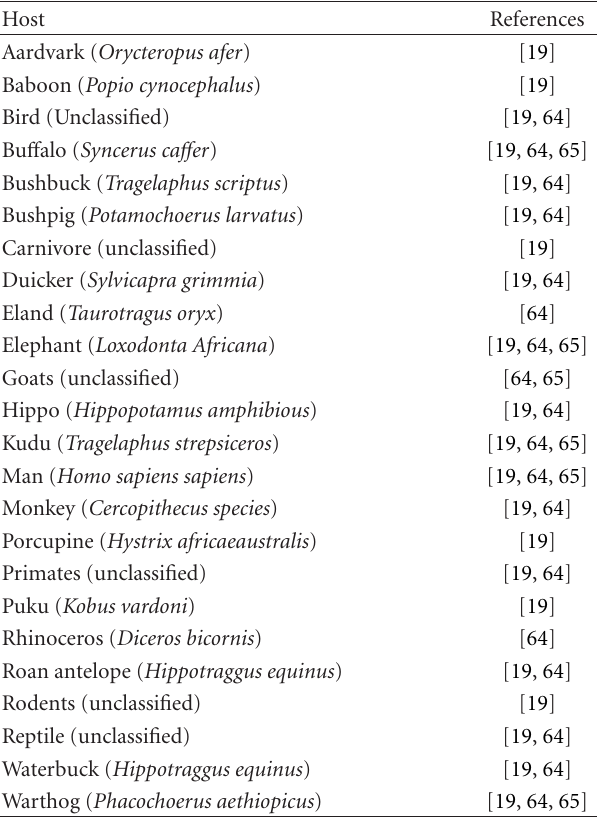
Table 3: Animal blood meals detected from Glossina spp . in Zam-